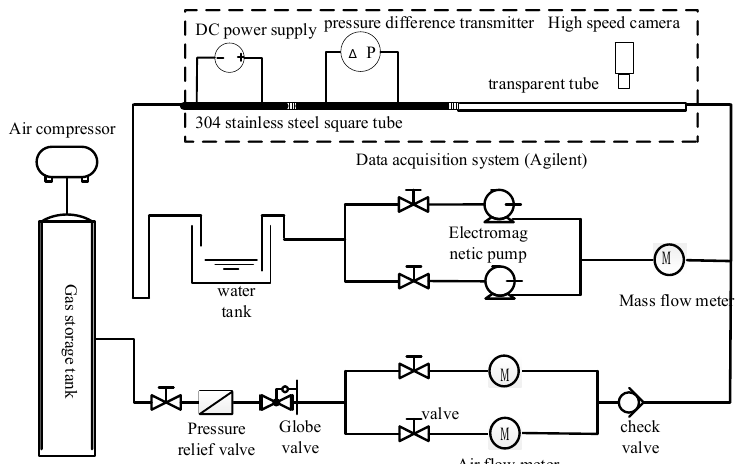
Figure 1. Experimental system diagram.